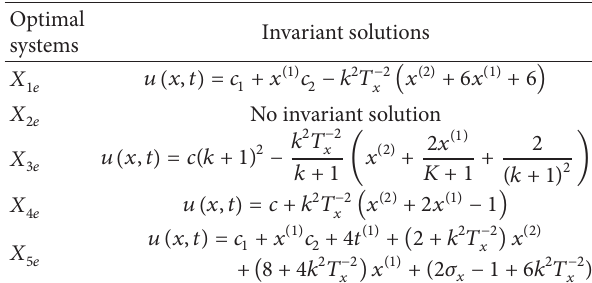
Table 2: The optimal systems for discrete harmonic oscillator and respective invariant solutions.